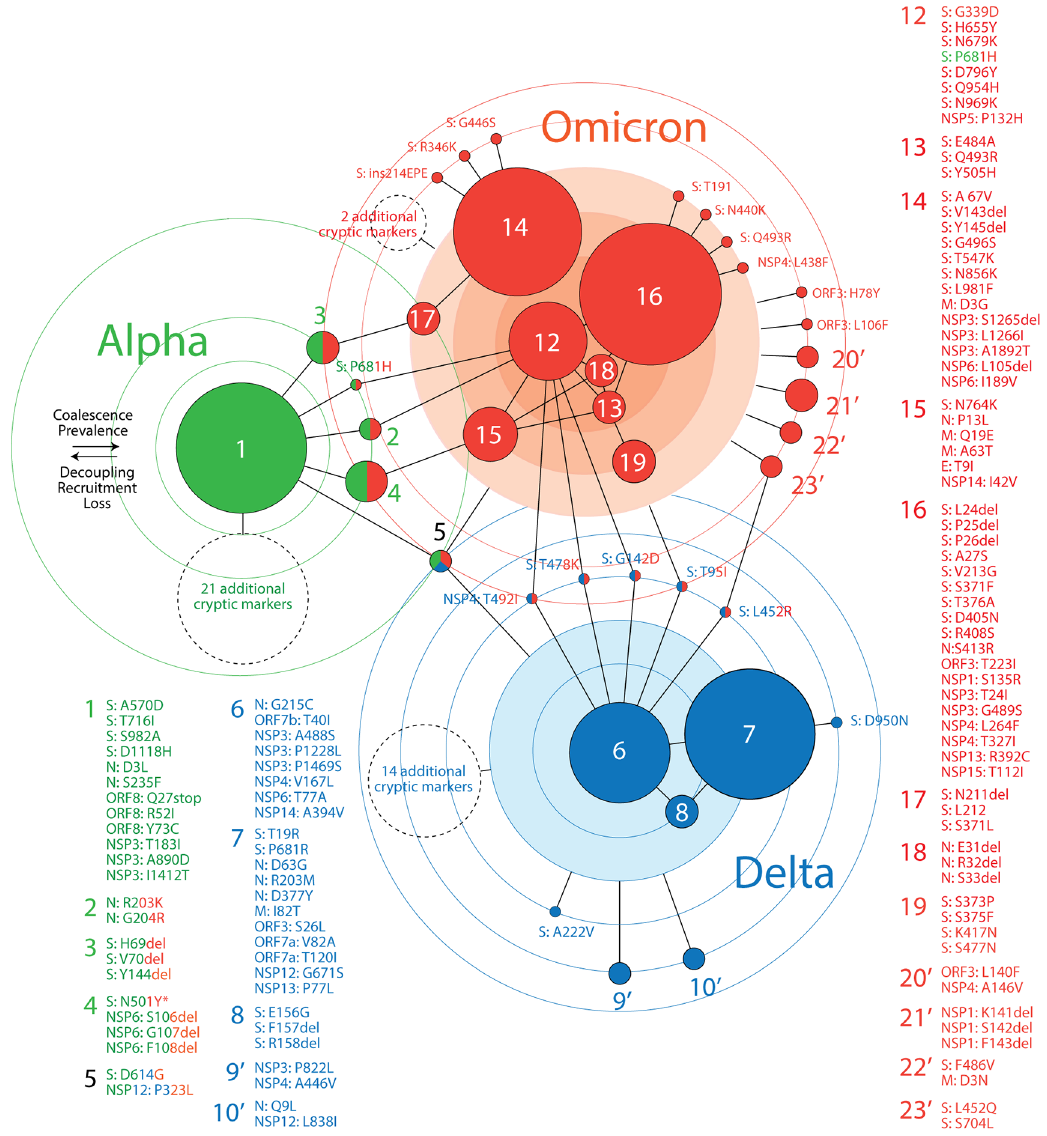
Figure 5. A network of haplotypes illustrating the worldwide emergence of major VOCs. Nodes and edges of the graph describe how haplotypes and free-standing mutations coalesce towards the inner-most circles of the major VOC constellations. Haplotype and mutant labels are colored according to their presence in VOCs worldwide. Cryptic markers are listed in Figure